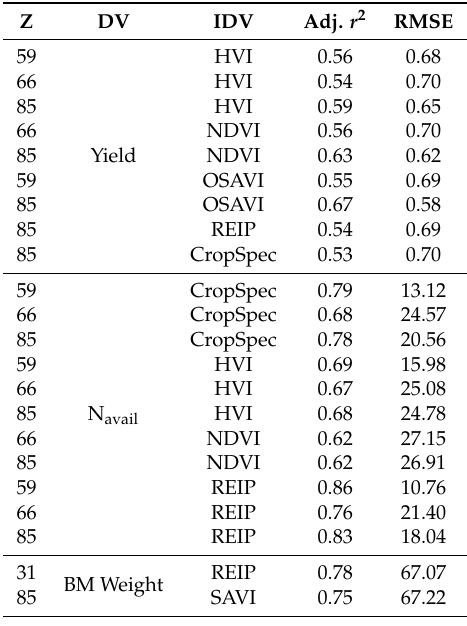
Table 7. Linear regression analysis of indices from spectrometer FieldSpec HandHeld for site-year 4. Z = Zadoks’ Scale, DV = Dependent Variable, IDV = Independent Variable, RMSE = Root mean square error, BM = Biomass. Significance level: p -value <